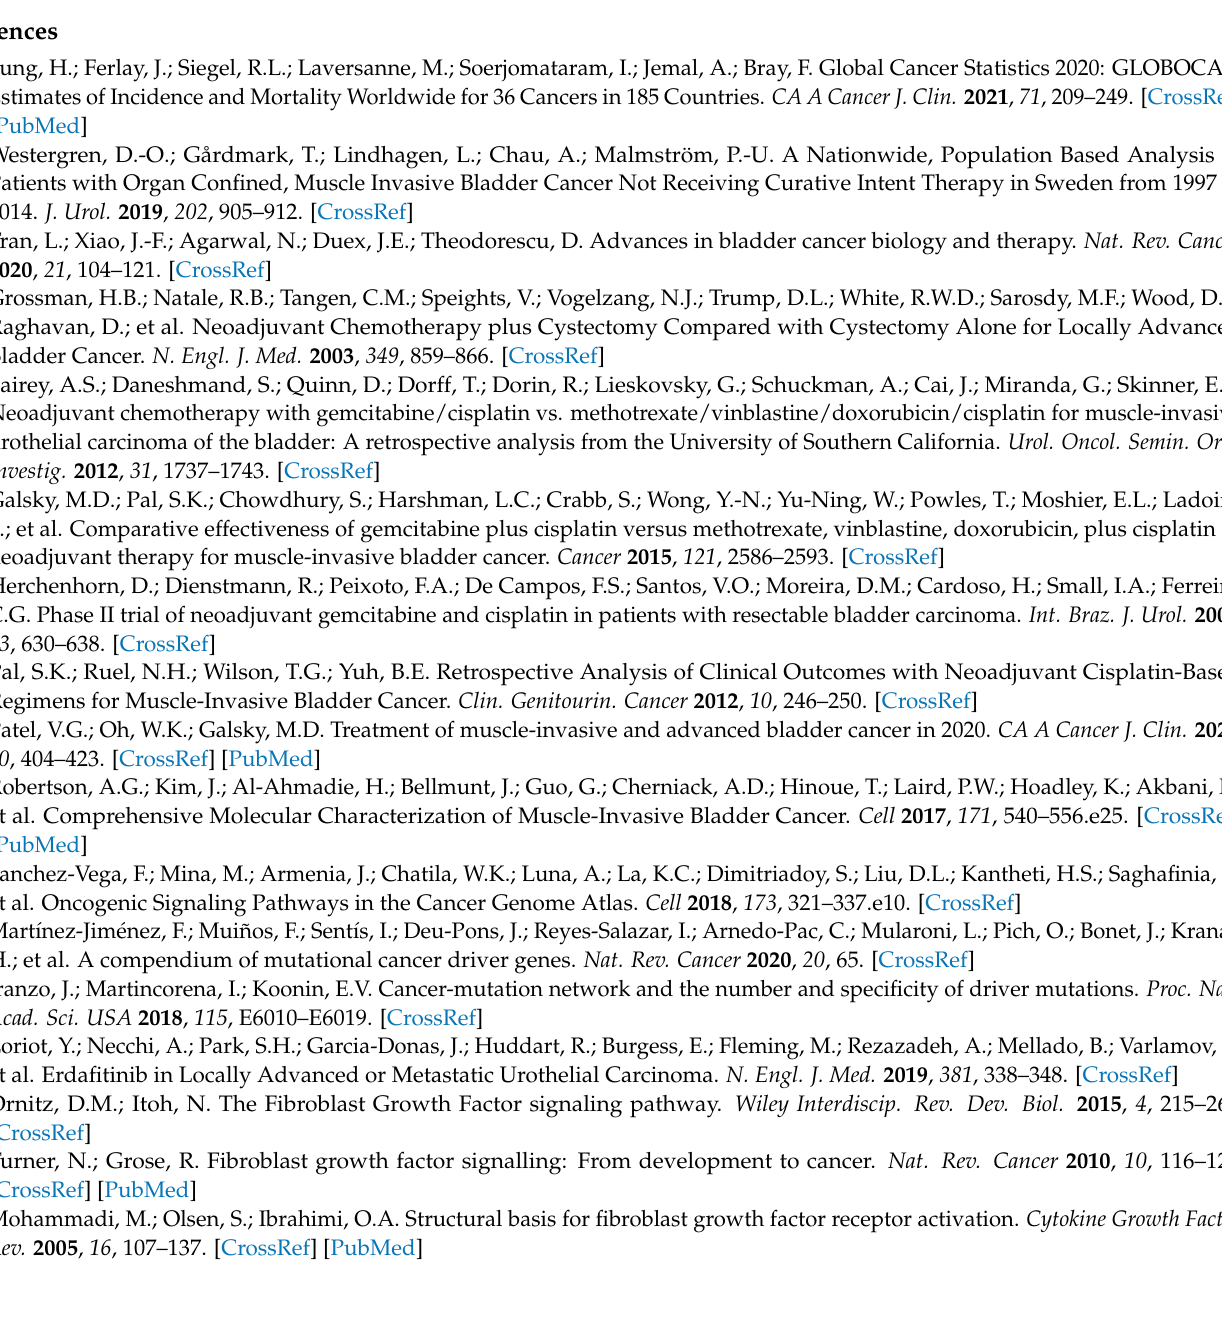
Figure. Conceptualization, J.-F.X. and D.T.; writing—original draft preparation, J.-F.X.;